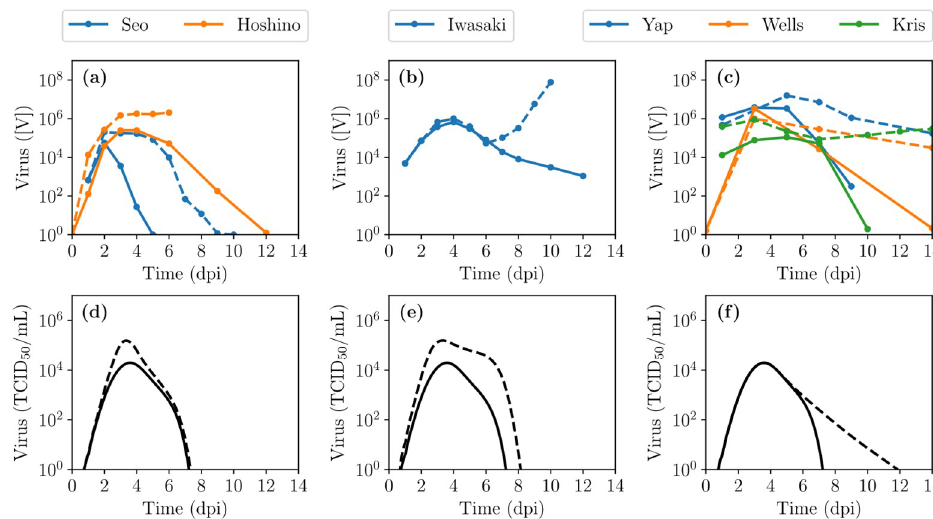
Fig 10. MM predictions vs experimental data of immune response knockout experiments. Experimental (top row) or MM-simulated (bottom row) viral titer time course for IAV infections with a full immune response (solid lines) or with one immune response component experimentally or mathematically disabled or knocked-out (dashed lines), respectively. Either (a,d) the IFN response [46, 55], (b,e) the Ab response [45] or (c,f) the CTL response [56–58] were disabled. In these experimental studies, the animal model is mice, except Seo et al. [55] which was conducted in pigs. Experimental viral load is measured in TCID 50 /mL for [55], in TCID 50 /mouse (of lung homogenate) for [46], in EID 50 /mL for [56], [58] and for [57] and in pfu/mL for [45]. The MM results are shown with f 50 = 0.5, k k C = 50 h − 1 , or disabled with F ( t ) = 0, A ( t ) = 0 or C ( t ) = 0 in (d,e,f),